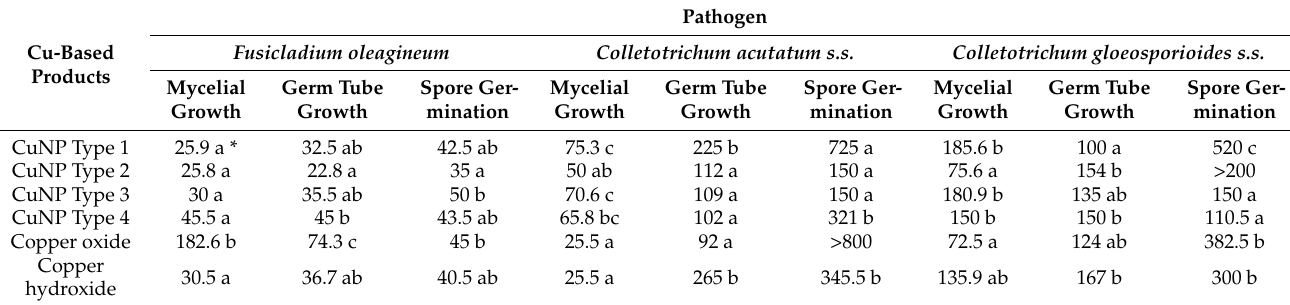
Table 2. Effective concentrations ( µ g · mL − 1 ) of Cu ++ and Cu-based nanoparticle (CuNP) fungicides, causing 50% inhibition (EC 50 values) of mycelial growth, spore germination, and germ tube growth of Fusicladium oleagineum , Colletotrichum